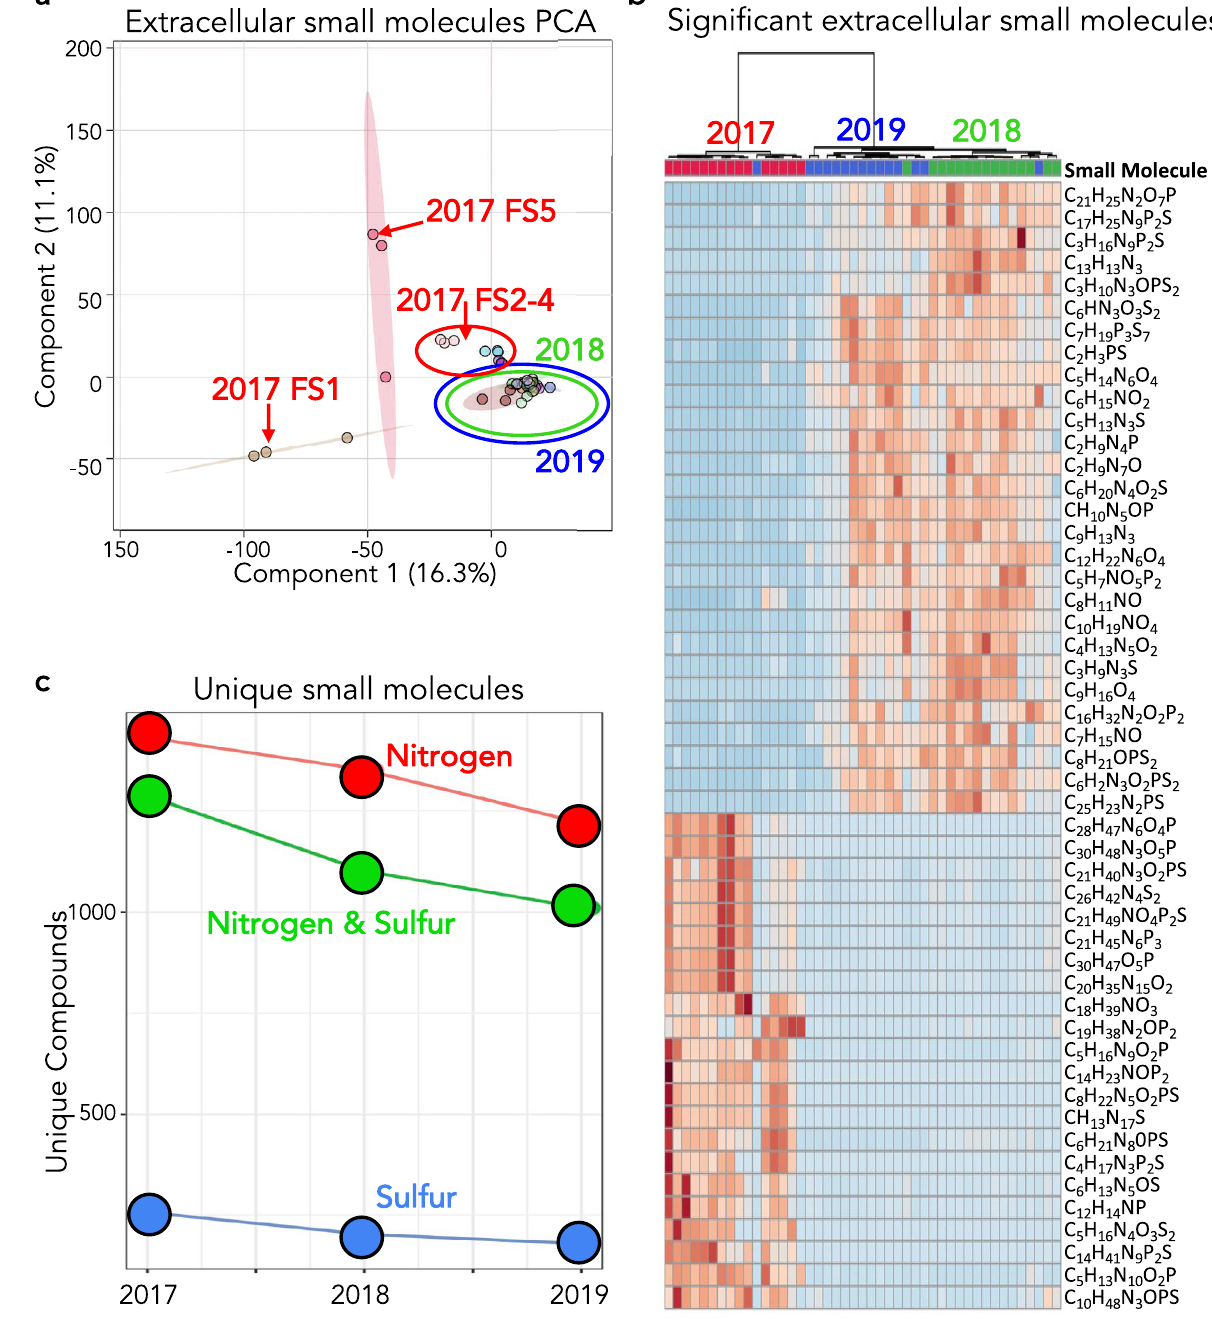
Figure 6. Extracellular small molecules were isolated and small molecule profiles were analyzed. ( a ) PCA for extracellular small molecules in the sediment. 2018 and 2019 group very closely together relative to 2017. FS2-4 from 2017 group together and are closer to 2018 and 2019 than FS1 and FS5 from 2017. ( b ) Heatmap of the top 50 discriminating small molecules between 2017, 2018 and 2019. The top of the figure showing the year of each sample with a dendrogram indicating that 2017 groups independently from 2018 and 2019. The figure was generated using MetaboAnalyst v4.0 ( c ) Plot showing unique sulfur, nitrogen and sulfur and nitrogen containing molecules. Element specific molecules are shown in each year from 2017 to 2019. Formulas were determined from the mass spectrometry datasets using an error of 15